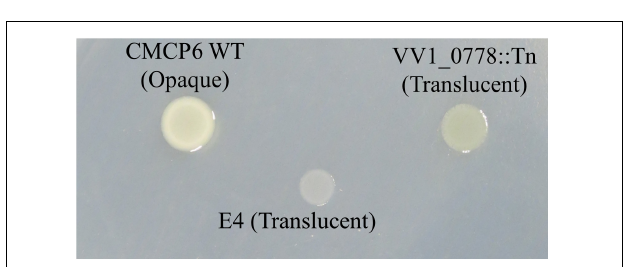
FIGURE 4 | Swarming motility of WT and the mutants lacked genes involved in the flagellum.